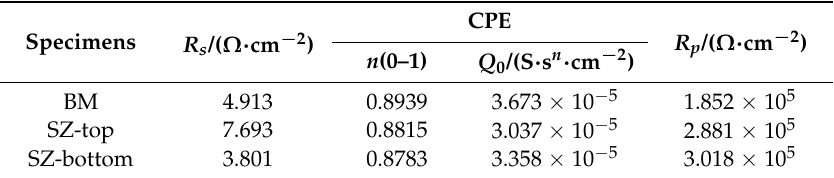
Table 2. Equivalent circuit parameters for BM, SZ-top and SZ-bottom in 3.5 wt. % NaCl solution